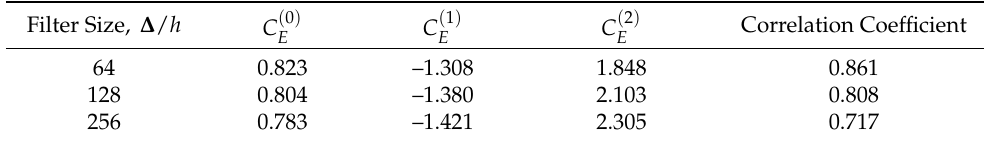
Table 1. Coefficients in the dissipation rate model (4) and